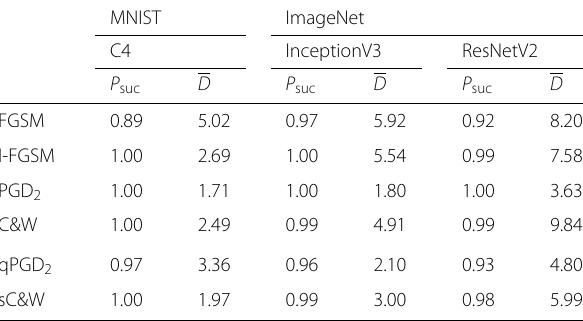
Table 1 Success probability P suc and average L 2 distortion D MNIST ImageNet C4